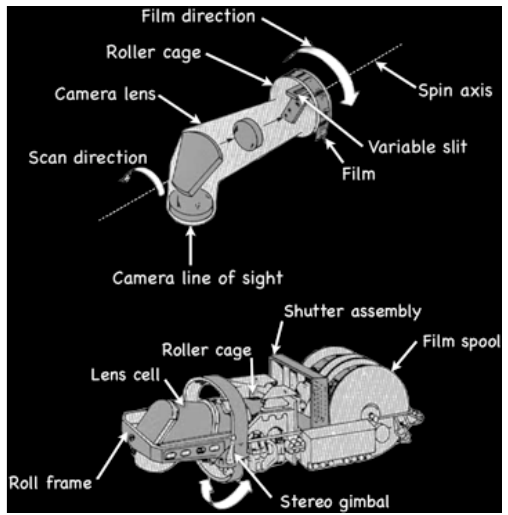
Figure 5: Top - PC roll frame assembly. Bottom - Stereo gimbal (NASA).